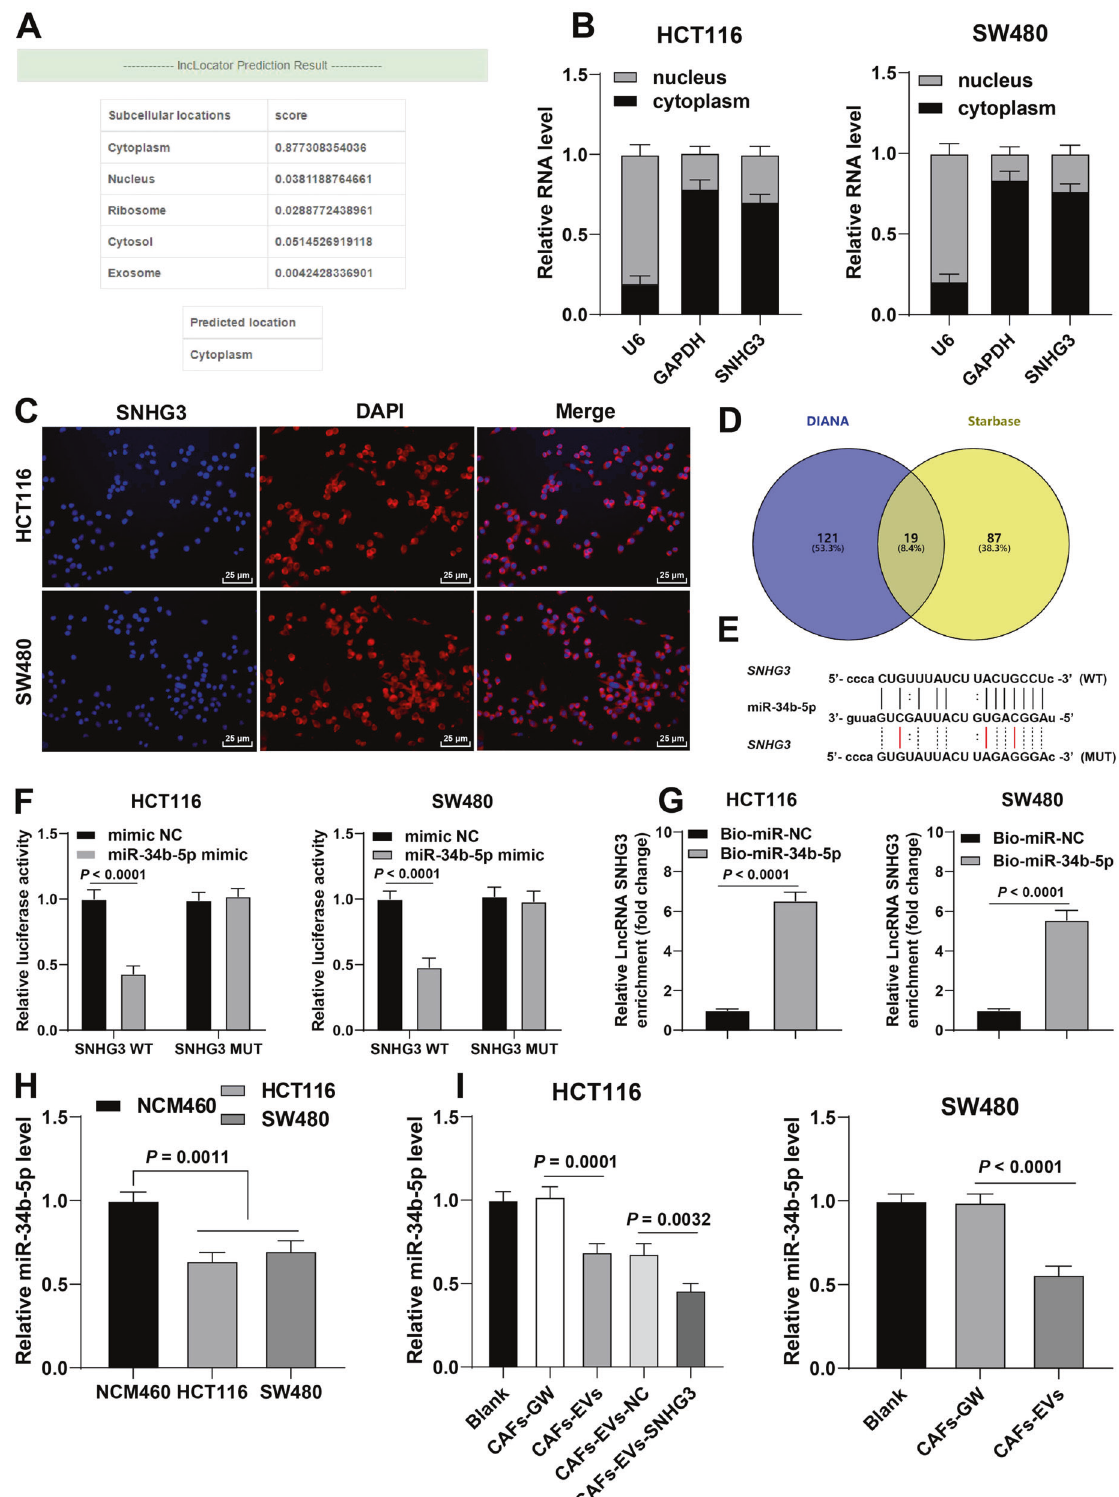
Fig. 4 SNHG3 inhibited miR-34b-5p expression. A The subcellular localization of SNHG3 through the lnclocator software. B , C The location of SNHG3 in CRC cells was veri fi ed using nuclear/cytosol fractionation assay and RNA FISH. D The downstream miRNAs of SNHG3 were predicted through DIANA and Starbase databases. E The binding site of SNHG3 and miR-34b-5p in the Starbase database. F , G The binding relationship between SNHG3 and miR-34b-5p was veri fi ed using dual-luciferase assay and RNA pull-down. H , I miR-34b-5p expression in NCM460 and CRC cells was determined using RT-qPCR. The cell experiment was repeated three times independently. Data are presented as mean ± standard deviation. Data in G were analyzed using t -test. Data in H , I were analyzed using one-way ANOVA, and data in F were analyzed using two-way ANOVA, followed by Tukey ’ s multiple comparisons